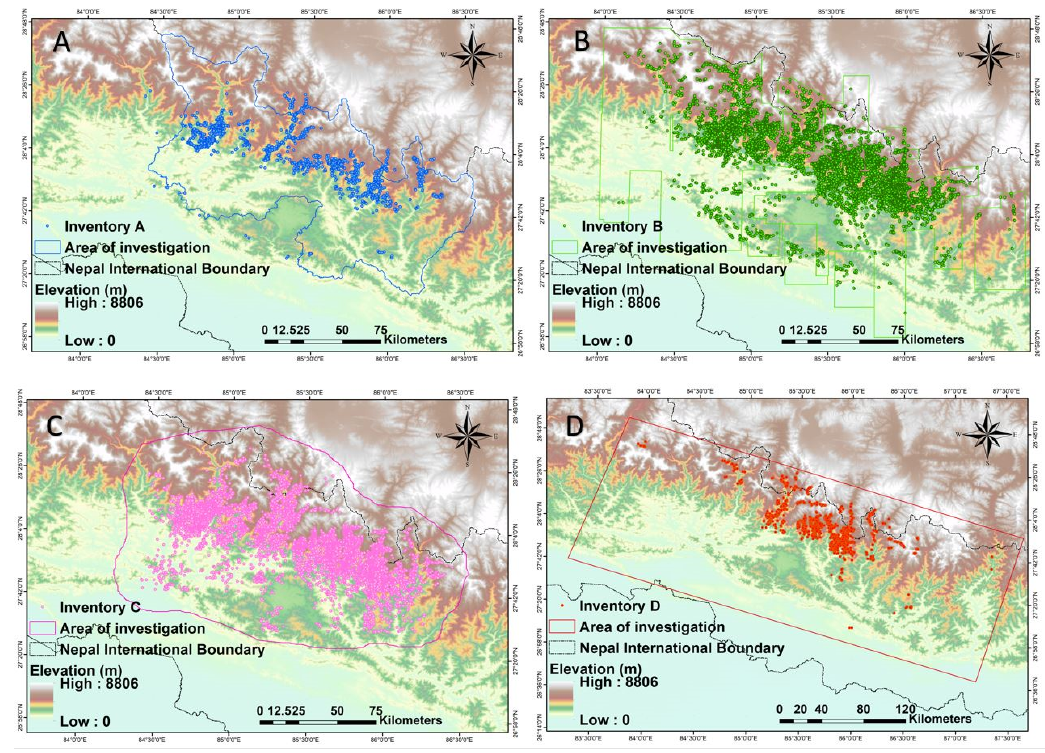
Figure 2. Landslide mapped after the 2015 Gorkha earthquake for the affected region. ( A ) Inventory A, ( B ) inventory B, ( C ) inventory C, and ( D ) inventory D.